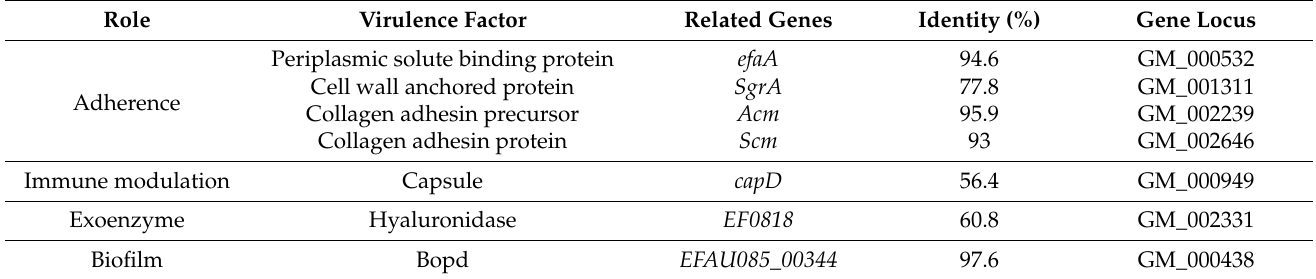
Table 3. Putative virulence factors encoded in the E. faecium FUA027 genome.